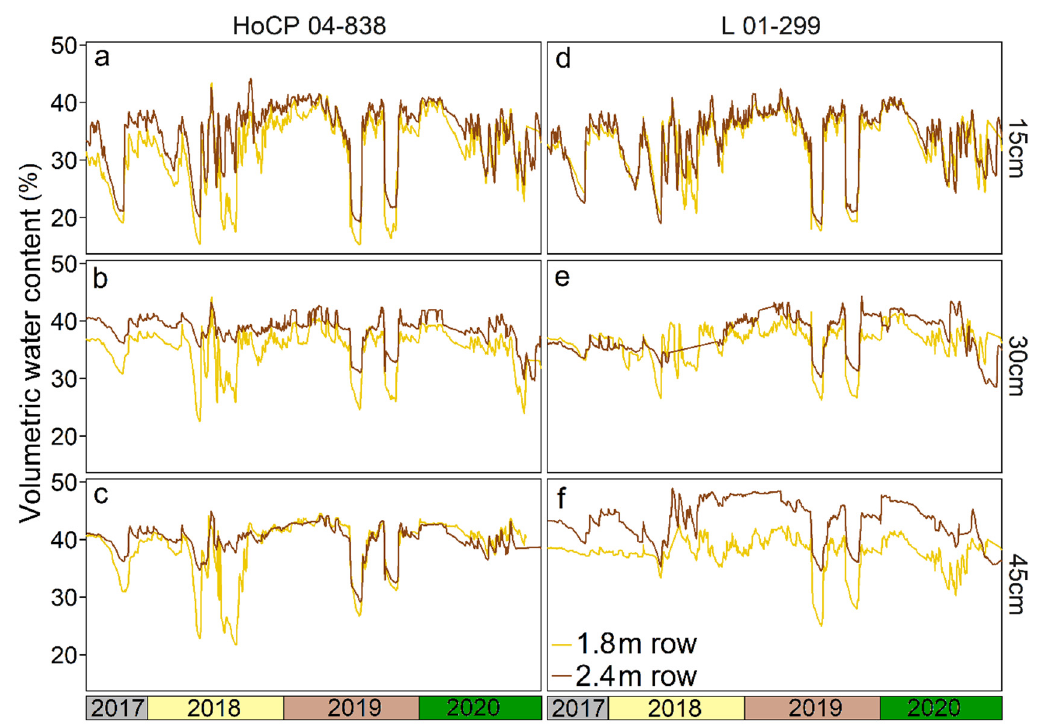
Figure 3. Volumetric water content (%) from September 2017 through September 2020. Row spacings of 1.8 and 2.4 m were represented by brown and yellow lines, respectively. Varieties included are HoCP 04-838 ( a – c ) and L 01-299 ( d – f ). Soil moisture sensors were placed at three depths: 15 cm ( a , d ), 30 cm ( b , e ), and 45 cm ( c , f ). Row spacing of 2.44 m had more water than 1.83 m row spacing. The standard deviation of the mean VWC values was less than ± 1% in 94.4% of the cases and less than 2% in 99.1% of the